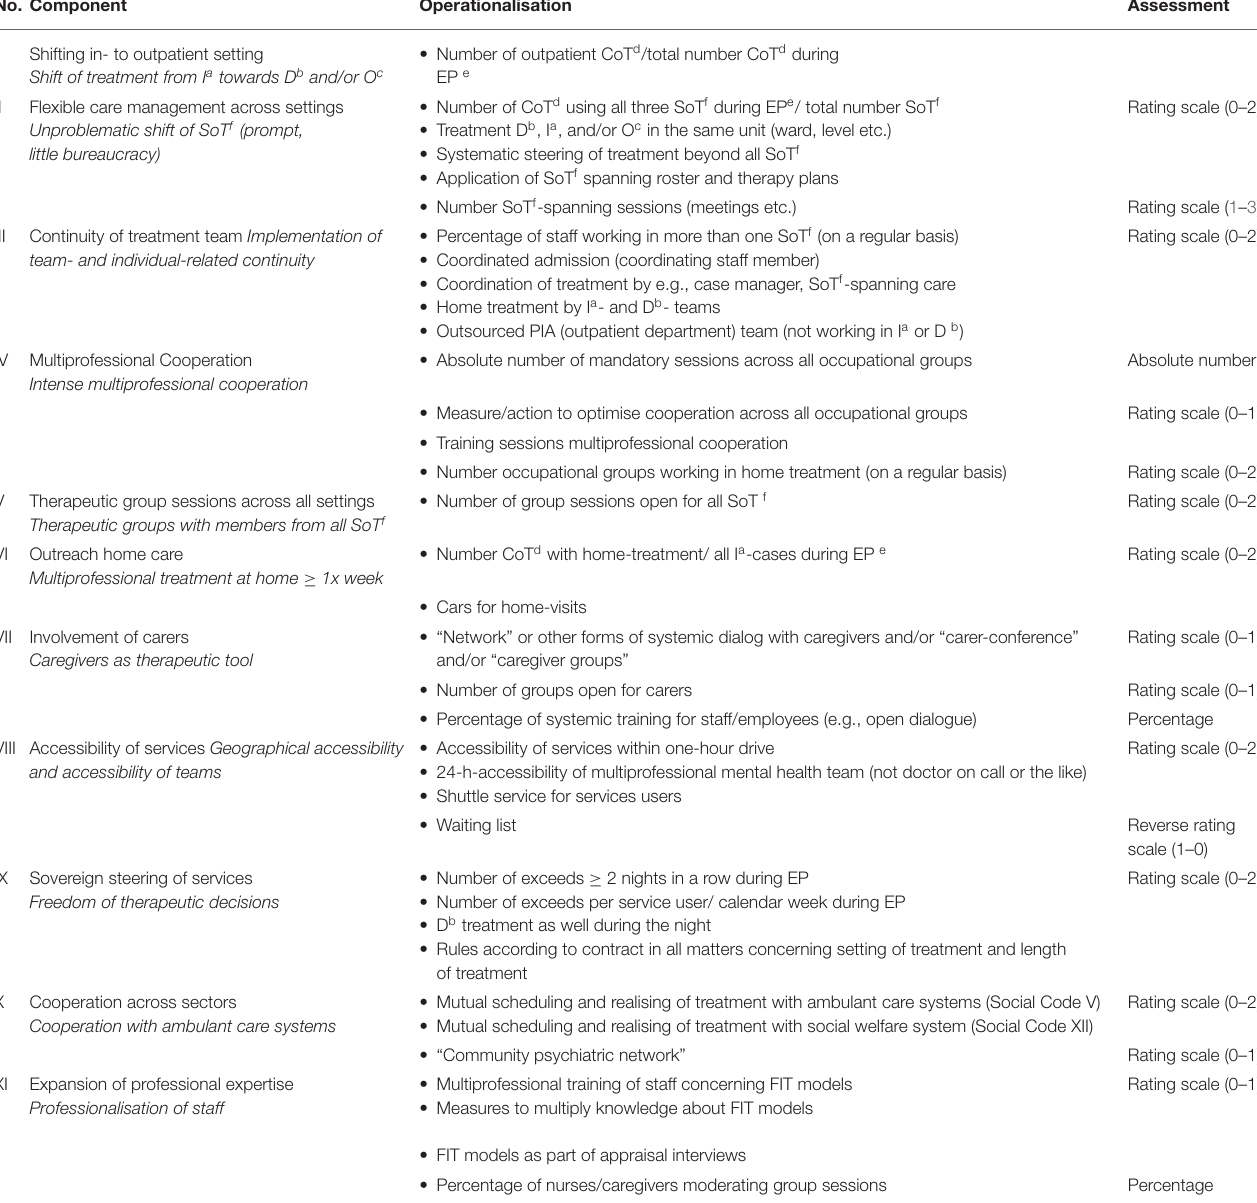
TABLE 2 | FIT-specific components and their operationalization according to Johne et al. (31). No.